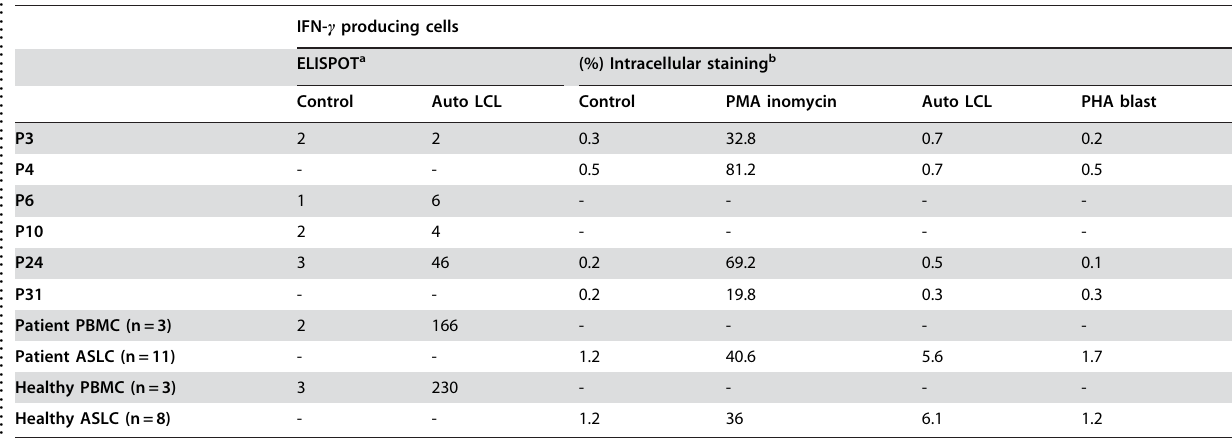
Table 5. Production of IFN c by TILs. .. ... .... ... ... .... ... ... .... ... ... .... ... ... .... ... ... .... ... ... .... ... ... .... ... ... .... ... ... .... ... ... .... ... ... .... ... ... .... ... ... .... ... ...